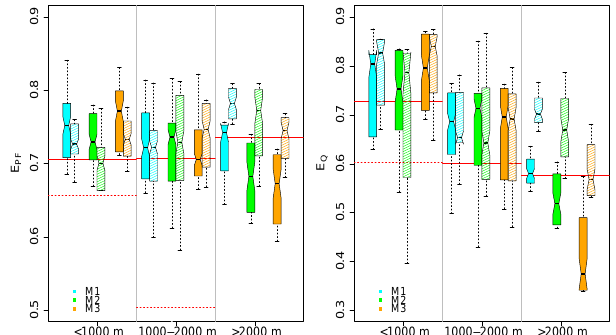
Figure 6. Results of the differential split-sample approach. E PF (left panel) and E Q (right panel) for each elevation class and snowmelt model. For the individual elevation classes and melt mod- els, the left box plots (darker colors) show the results for the calibra- tion period, and the right box plots (lighter colors) show the results for the validation period. The whisker boxes represent the median (center line), the interquartile range (25th–75th percentile; box out- line) and highest/lowest performance within the interquartile range ( ± 1.5 times of the interquartile range; whiskers). The benchmark performance is denoted by a solid red line (upper benchmark) and a dashed red line (lower benchmark), and the latter only displayed if within the range of the axis